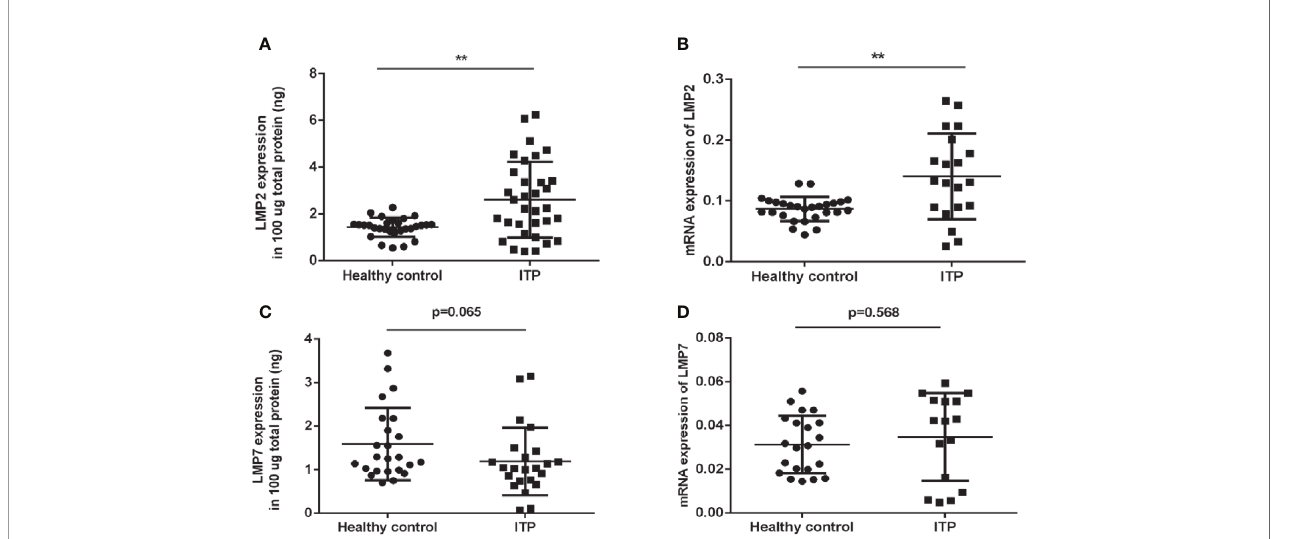
FIGURE 1 | LMP2 protein and mRNA expression are upregulated in ITP patients. (A) Immunosubunit LMP2 protein expression in ITP patients (n=33) and healthy controls (n=29) were assayed by ELISA. (B) LMP2 mRNA expression in ITP patients (n=20) and healthy controls (n=27) were determined by qPCR. (C) Immunosubunit LMP7 protein expression in ITP patients (n=23) and healthy controls (n=24) were assayed by ELISA. (D) LMP7 mRNA expression in ITP patients (n=16) and healthy controls (n=21) were determined by qPCR. Differences between patients and controls were compared by a Student-Newman-Keuls test. Bars represent SD; **P < 0.01.